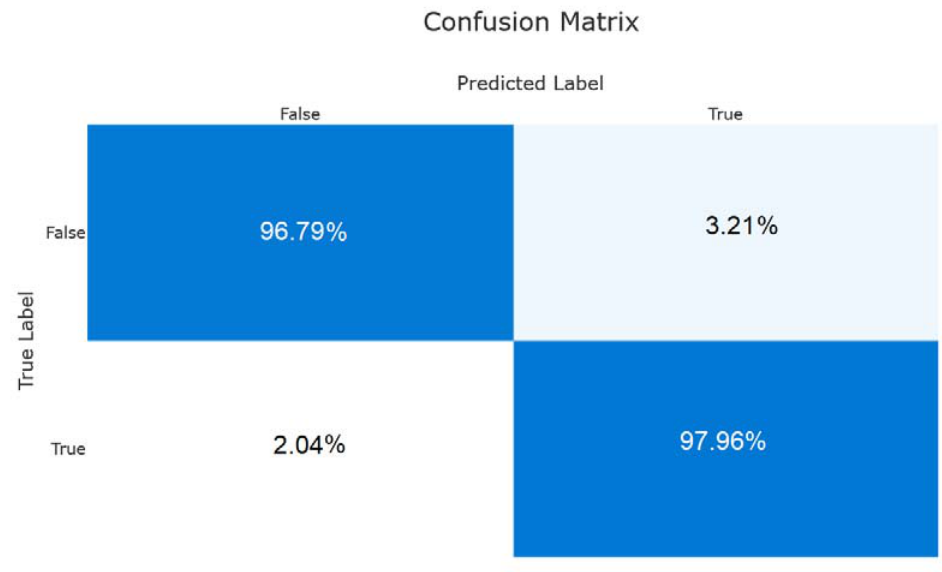
Figure 5. Confusion matrix.